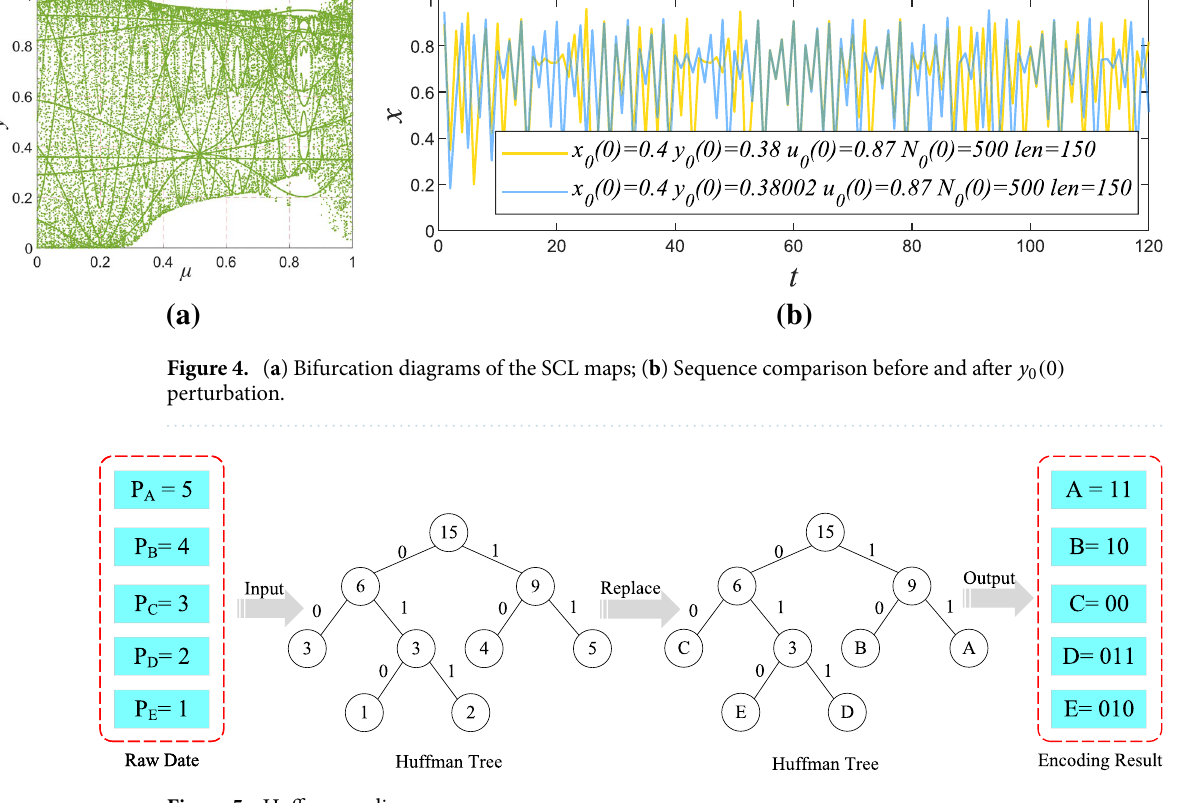
Figure 5. Huffman coding